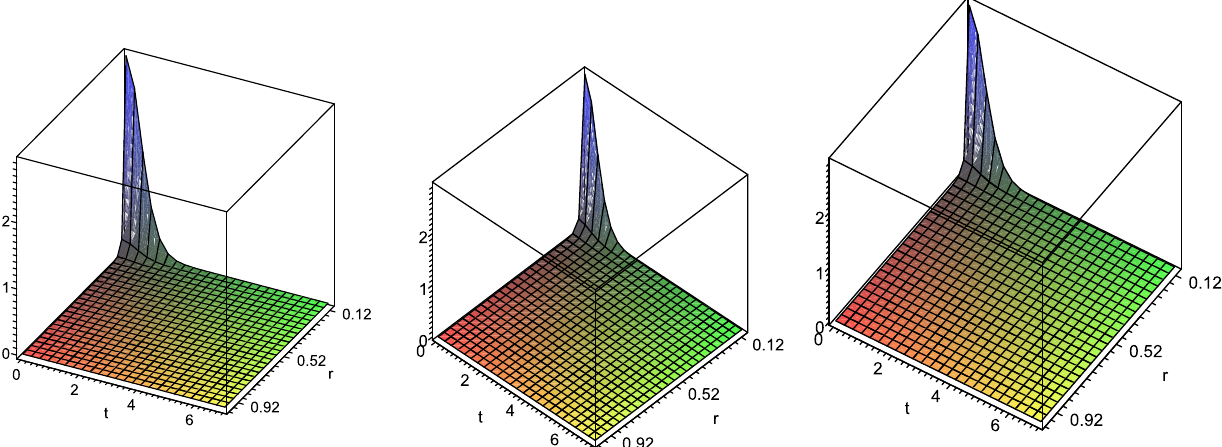
Fig. 7 The behavior of ρ , ρ + p r and ρ + p t versus r and t respectively from left to right, for w = − 1, r 0 = 0 . 1, R 4 = 1 and α = − 0 . 5 in